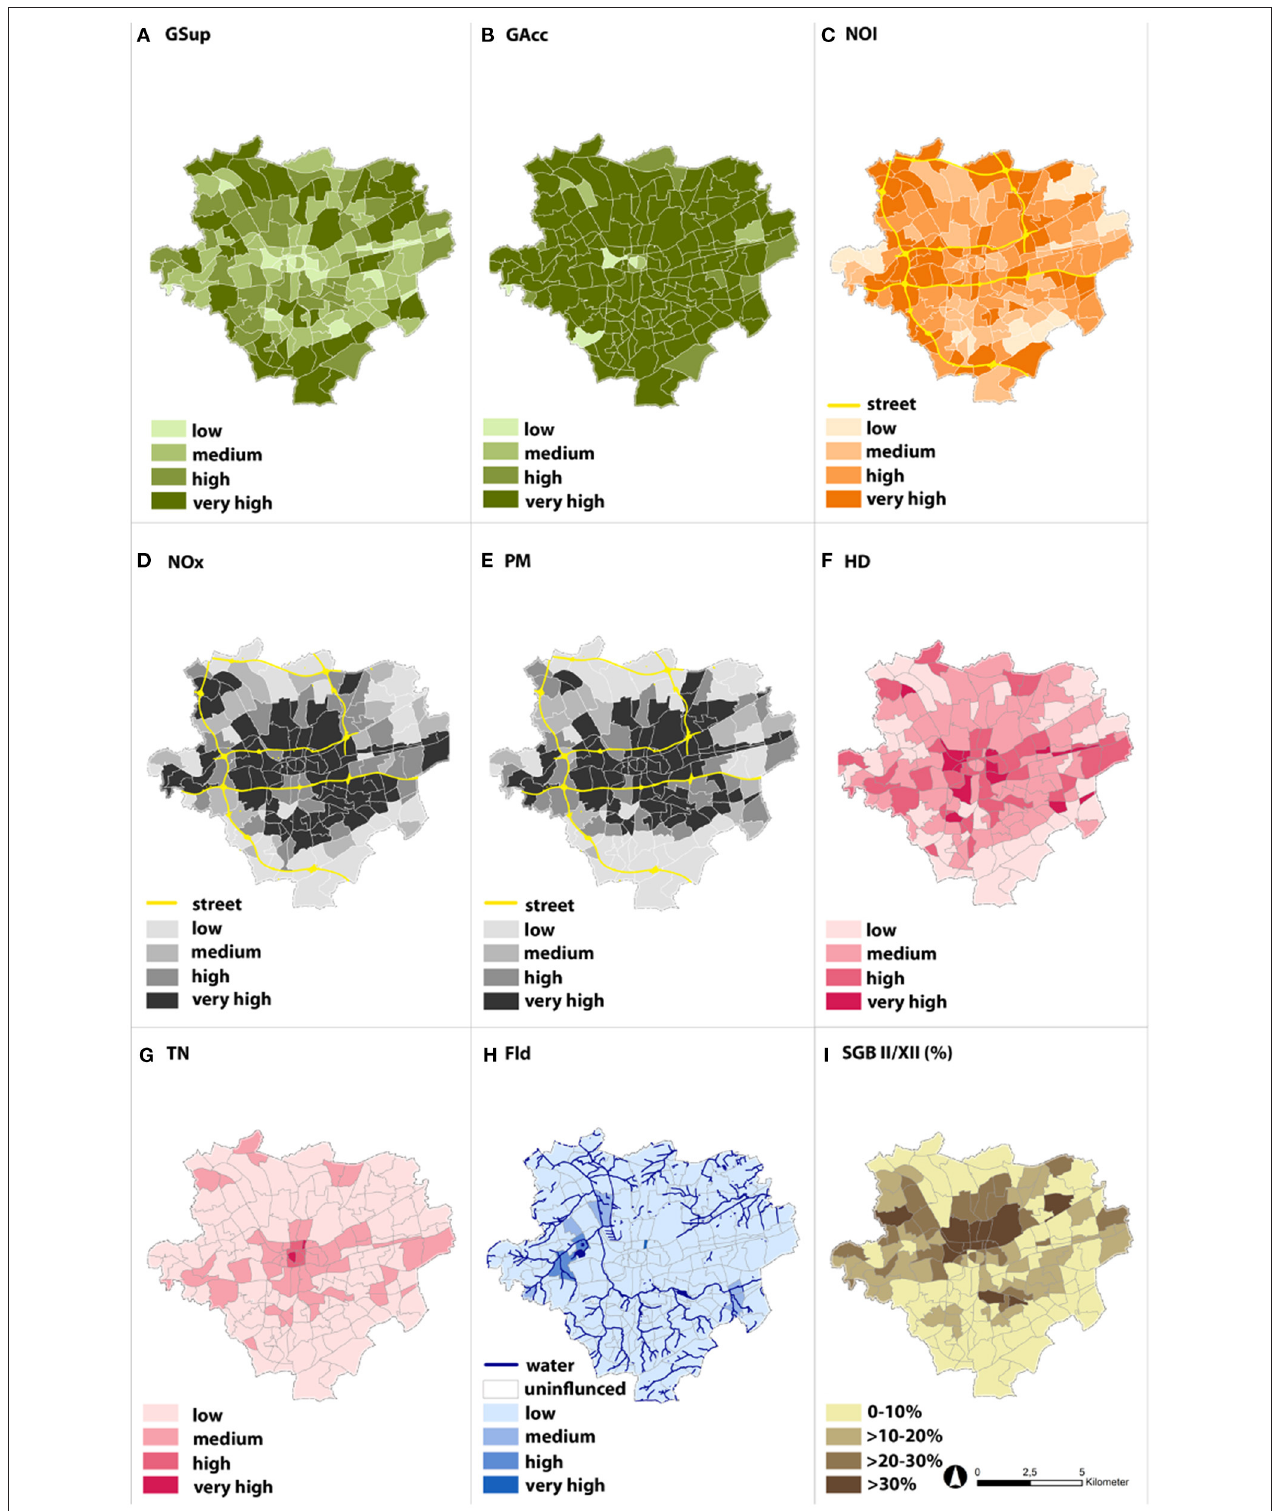
FIGURE 5 | Result of spatial analysis for each indicator (Dortmund) (source: Bakunowitsch et al., 2019, 124).